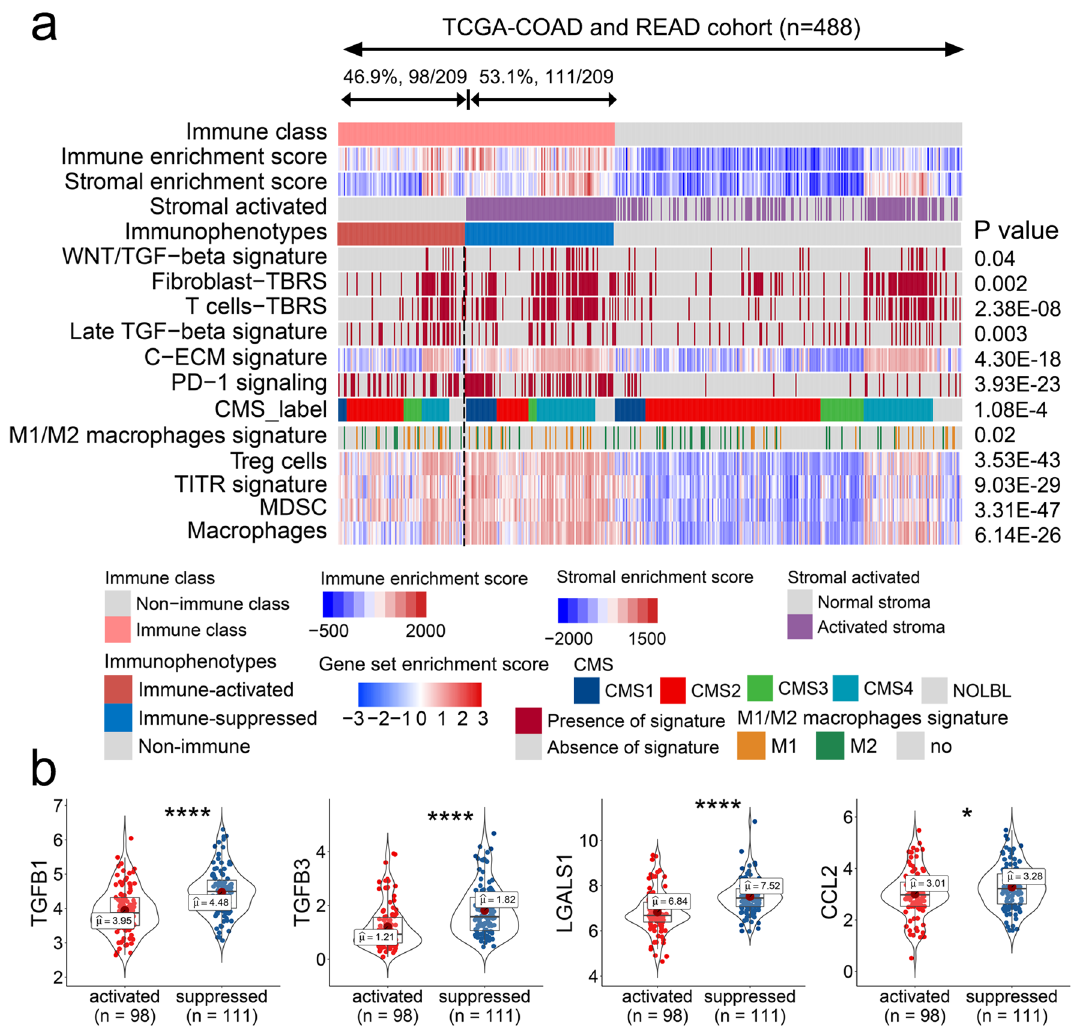
Figure 3. Identification of the immune-activated and immune-suppressed subclasses of colorectal cancer based on immunosuppressive signaling. ( a ) Heatmap showing the gene set variation analysis scores of immune- related signatures reported previously and the predicted result of the signature calculated by considering nearest template prediction between the immune and non-immune classes. ( b ) Expression of genes related to immune suppression between the immune-activated and immune-suppressed